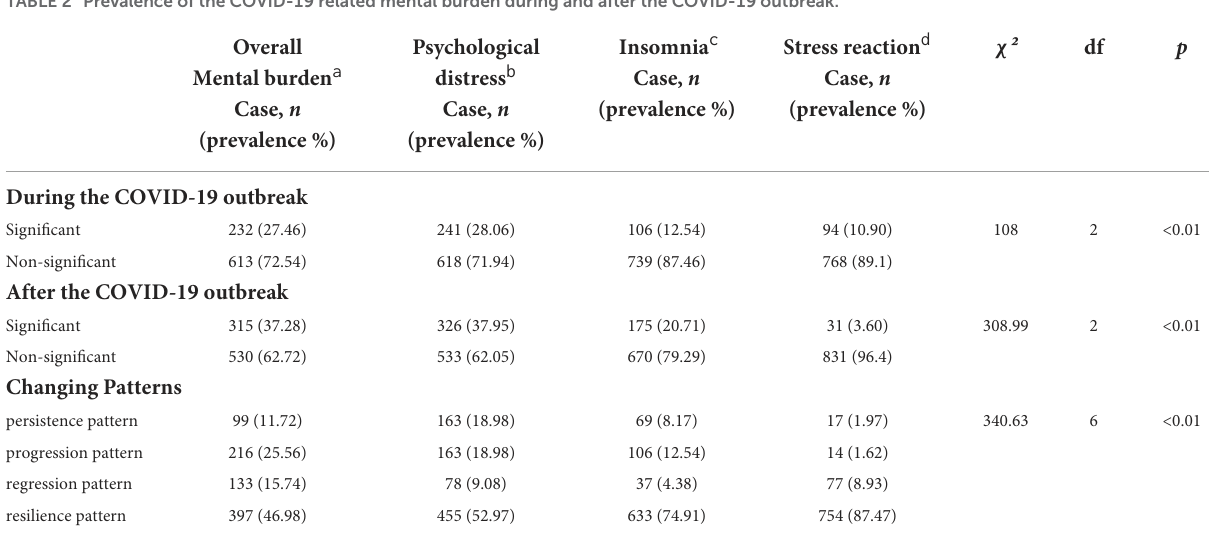
TABLE 2 Prevalence of the COVID-19 related mental burden during and after the COVID-19 outbreak.